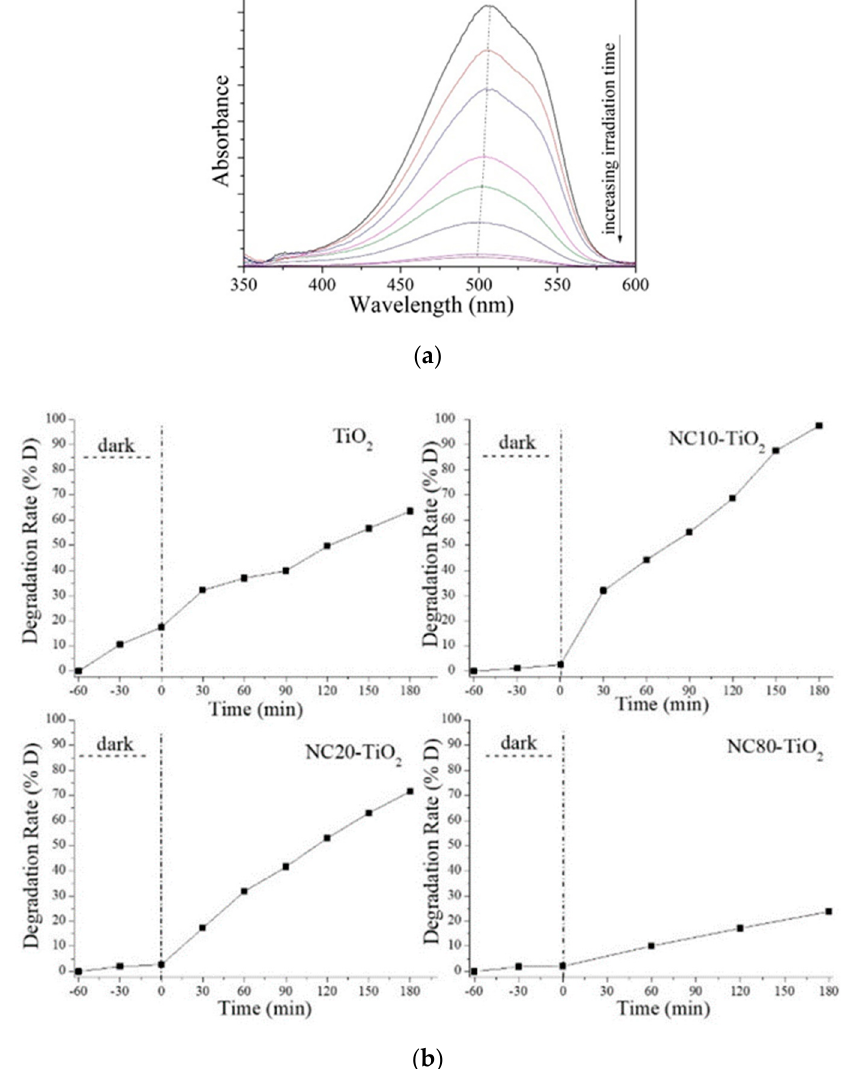
Figure 5. ( a ) Time–dependent UV–vis spectra of methyl orange and its degradation by NC10–TiO 2 under UV irradiation; ( b ) quantitative evaluation of photocatalytic degradation rate of methyl orange by TiO 2 , NC10–TiO 2 , NC20–TiO 2 , and NC80–TiO 2 under UV illumination.